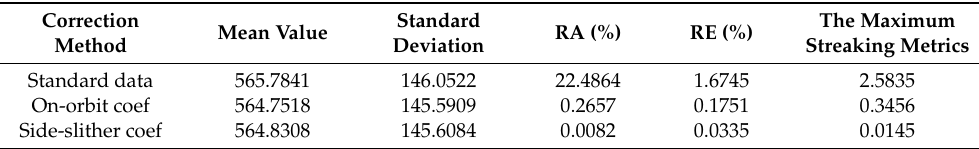
Table 2. Comparison of quantitative values of the images (coef: